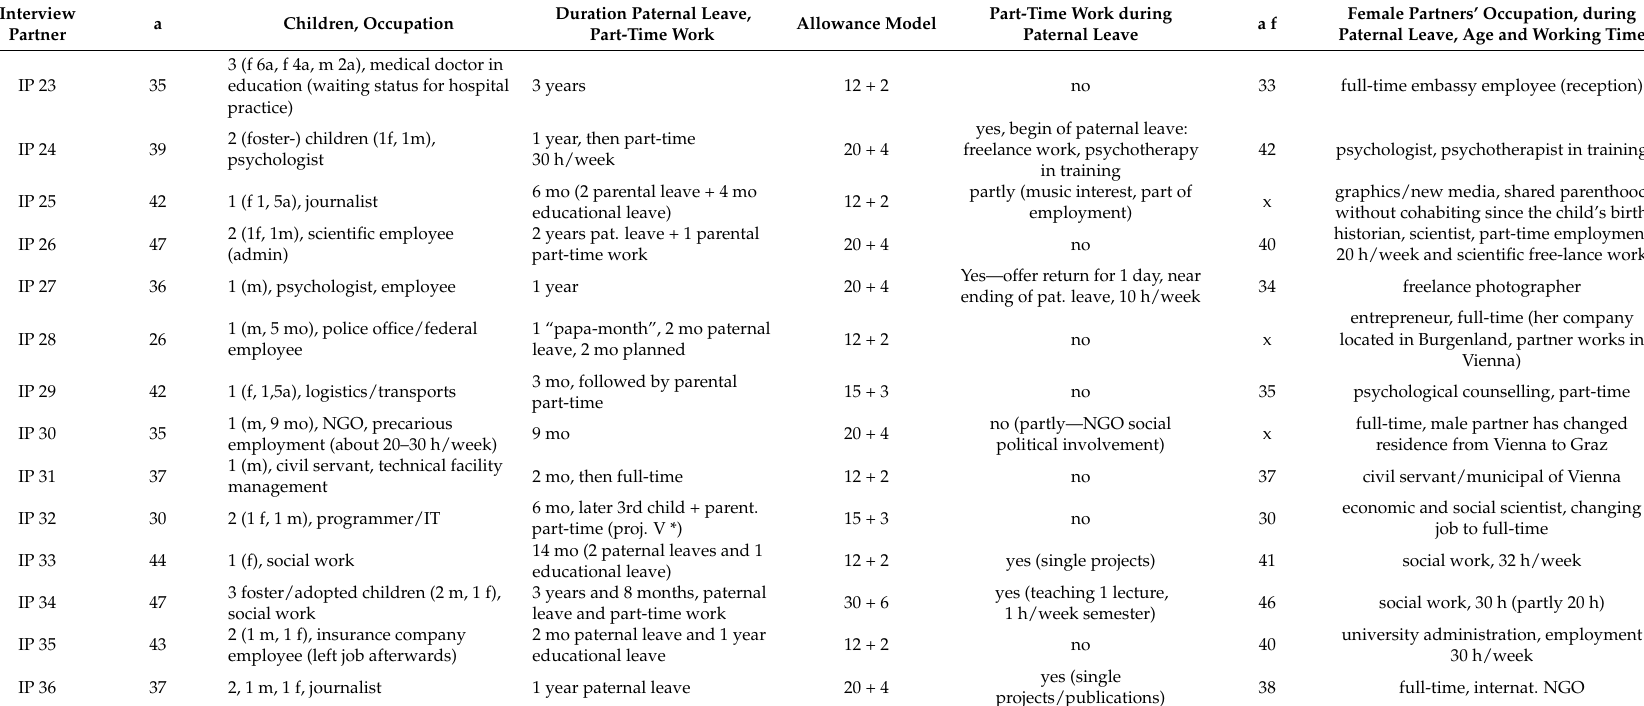
Table 3. Interview partners Project